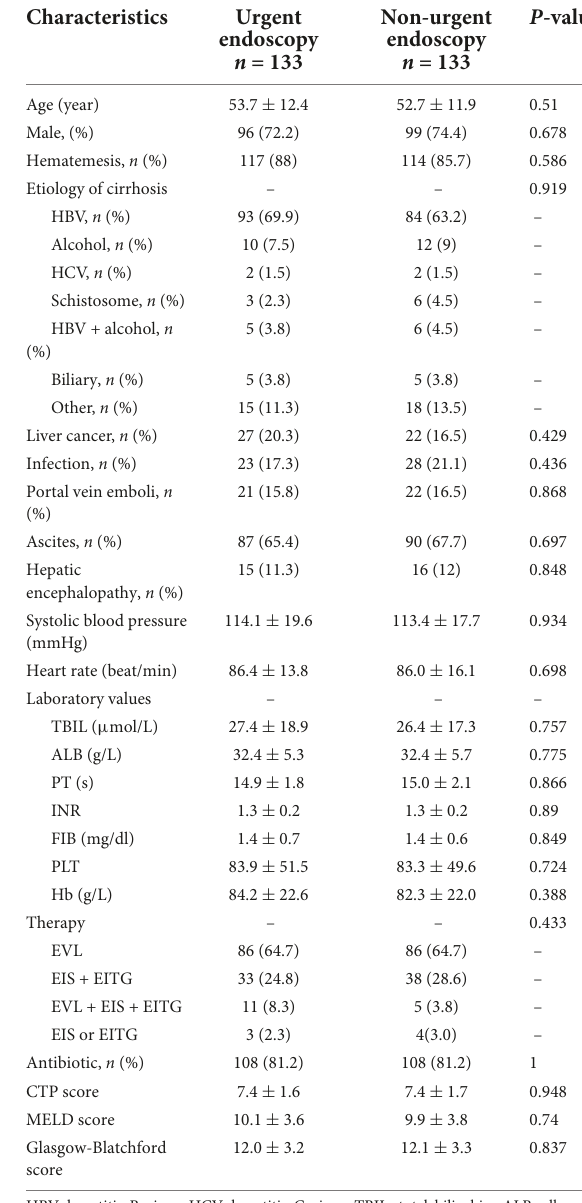
TABLE 2 Baseline characteristics of patients in urgent ( ≤ 12 h) and non-urgent ( > 12 h) endoscopy after propensity score matching